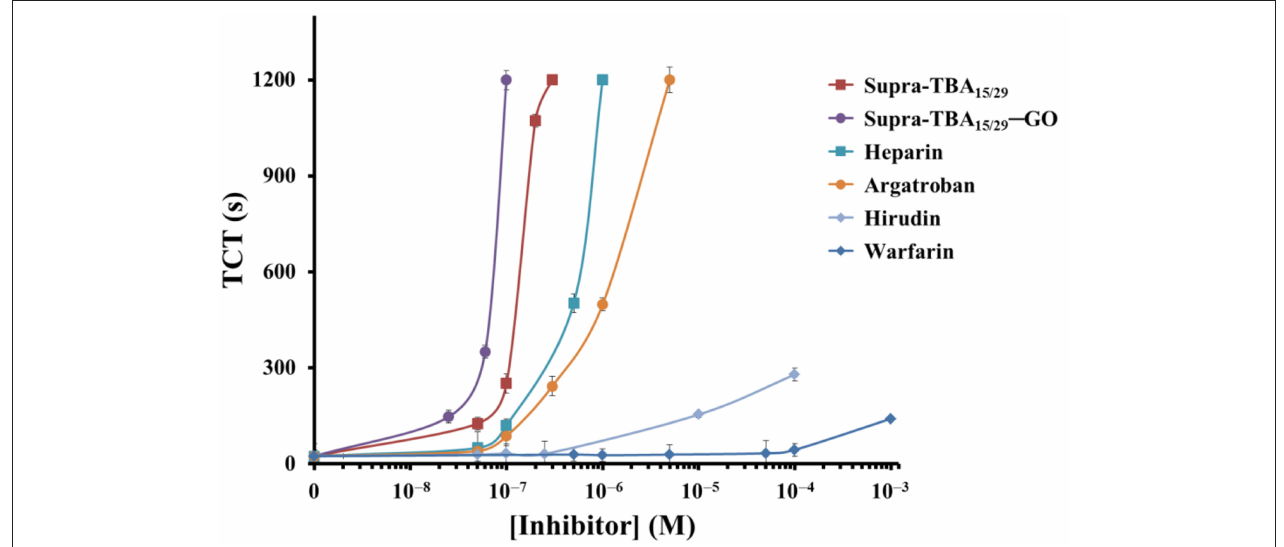
FIGURE 3 | Dose-dependence of the TCTs in human plasma in the presence of Supra-TBA 15 / 29 , Supra-TBA 15 / 29 -GO and commercial drugs heparin, argatroban, hirudin, and warfarin. The longest clotting assay time recorded was set at 1,200s. Error bars represent the standard deviations of experiments in triplicate. Other conditions were the same as those described in Figure 1